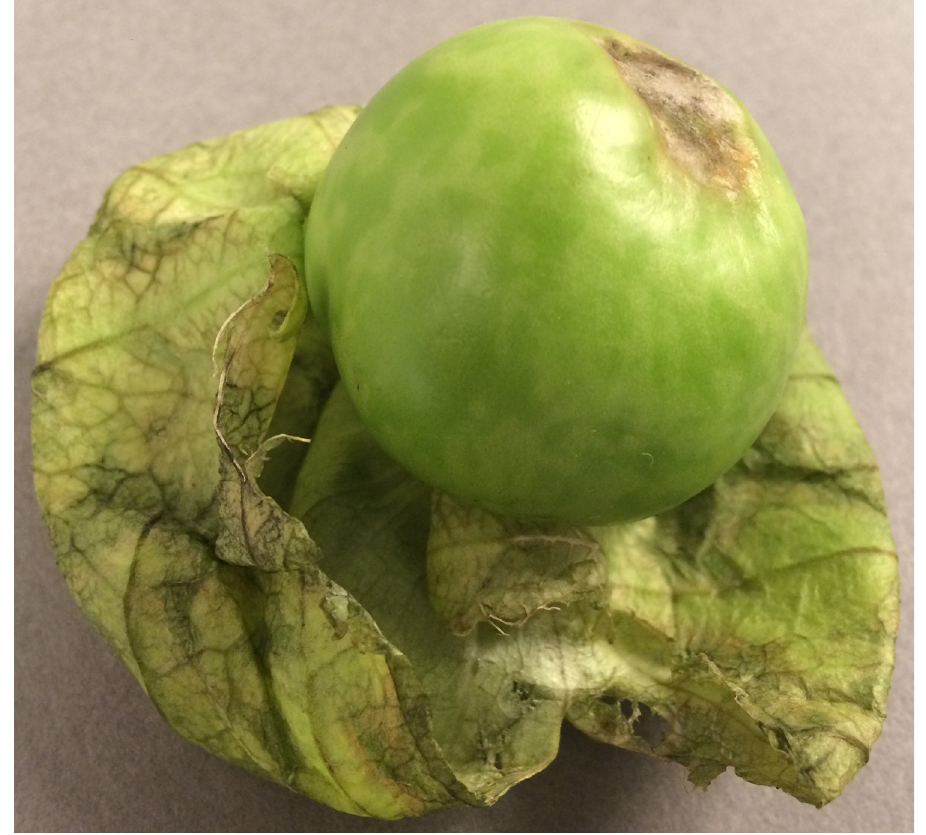
Fig 1. Solanum macrocarpon fruit with diffuse chlorotic mottling.